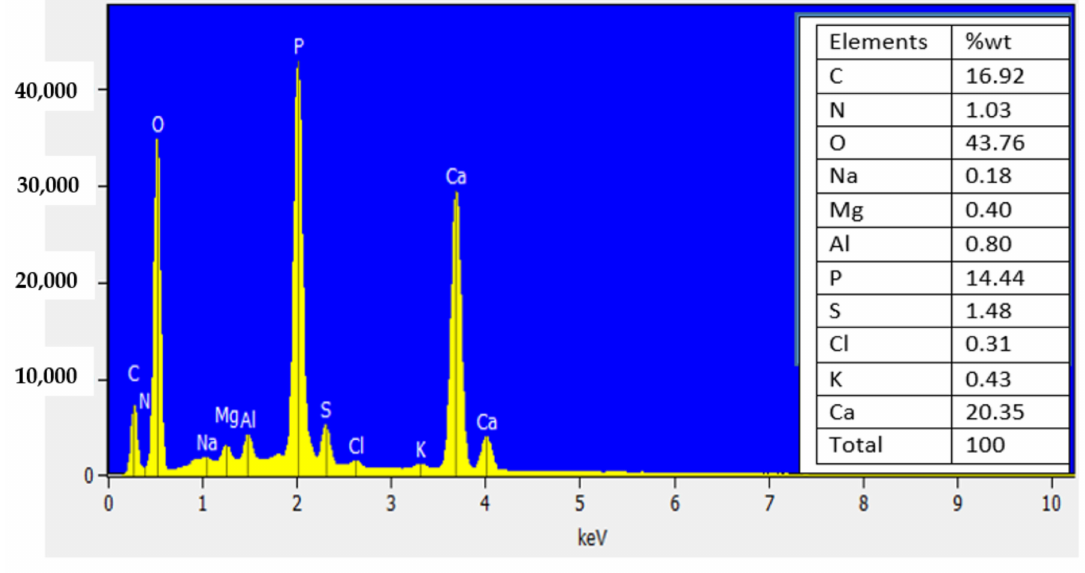
Figure 2. Elemental analysis of the